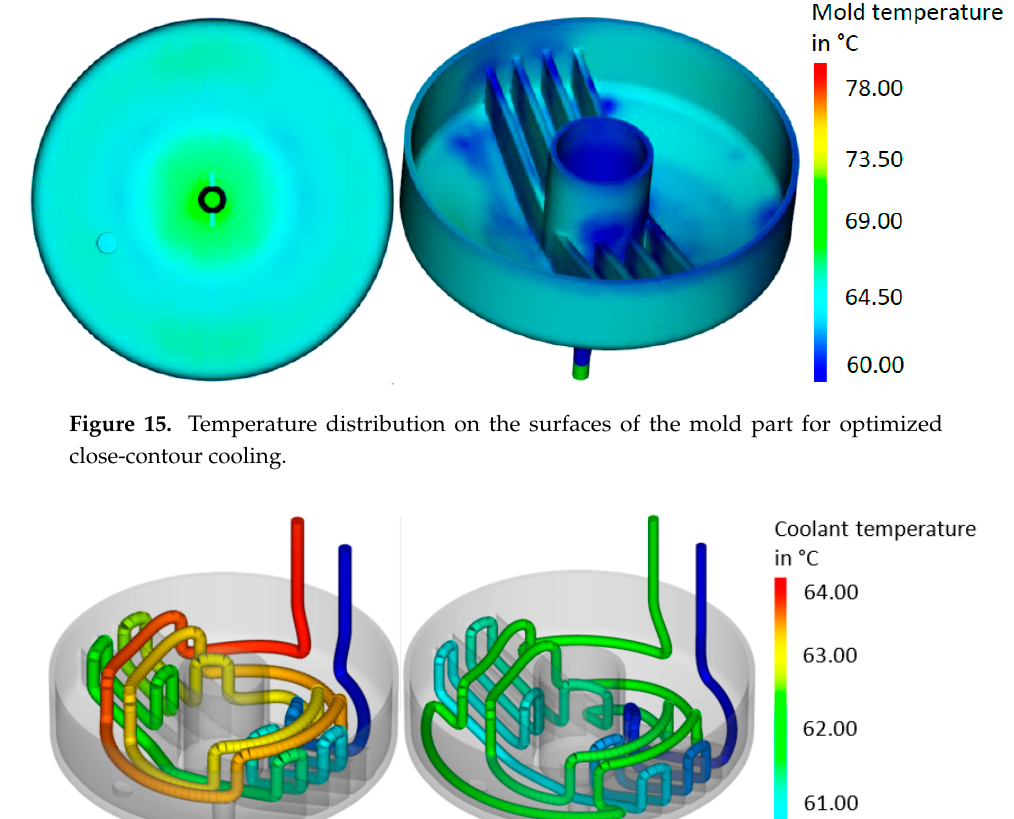
Figure 14. Temperature distribution in the tool cavity for close-contour cooling: a comparison be- tween initial configuration ( left ) and optimized configuration ( right ).